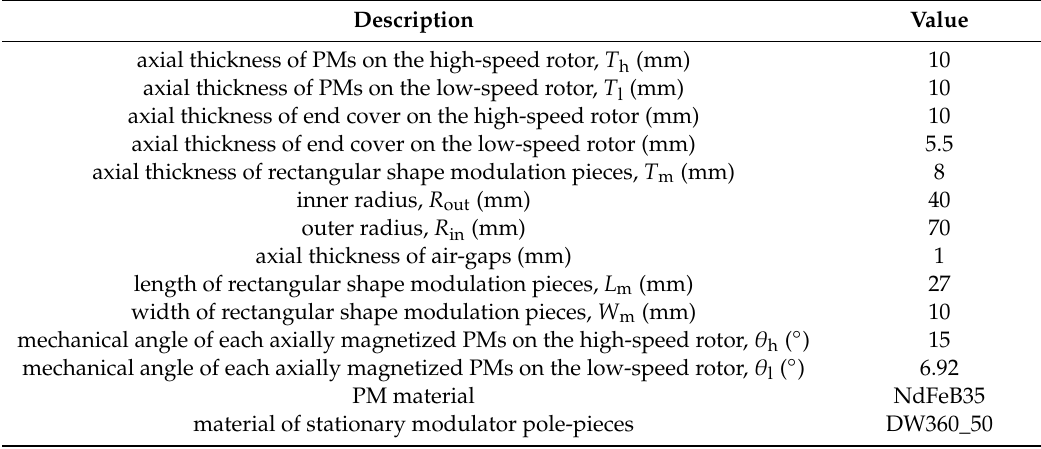
Table 1. Key parameters of the